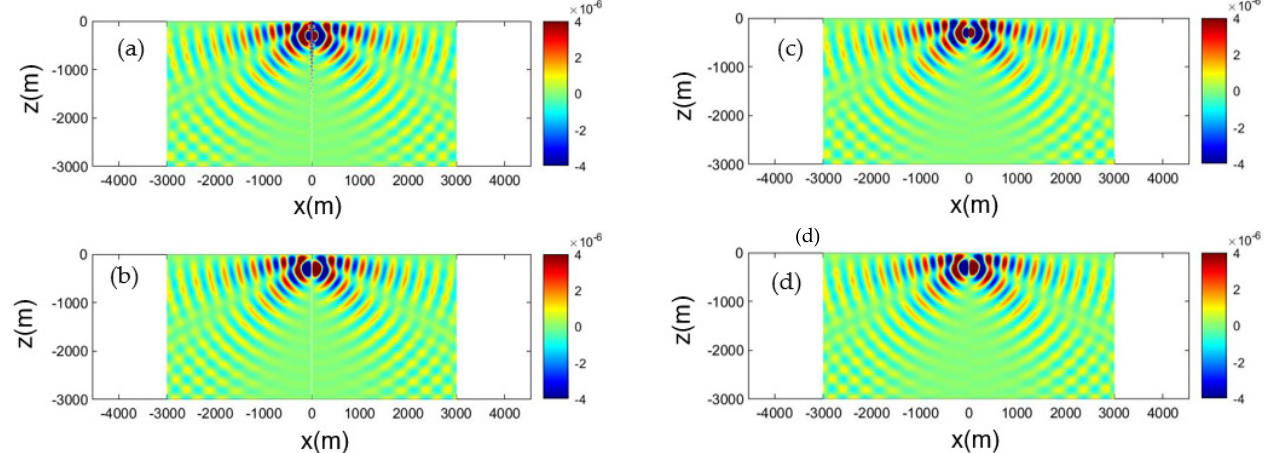
Figure 5. Calculated acoustic field corresponding to the horizontal dipole source, Equation (23). Source frequency 5 Hz, at submergence depth z 0 = − 300 m, in an isovelocity c = 1500 m/s ocean acoustic waveguide of depth h = 3000 m. Left column result obtained by the normal mode series, keeping 40 terms: ( a ) real part, ( b ) imaginary part. Right column: field obtained from the mirror series using six terms: ( c ) real part, ( d ) imaginary part.